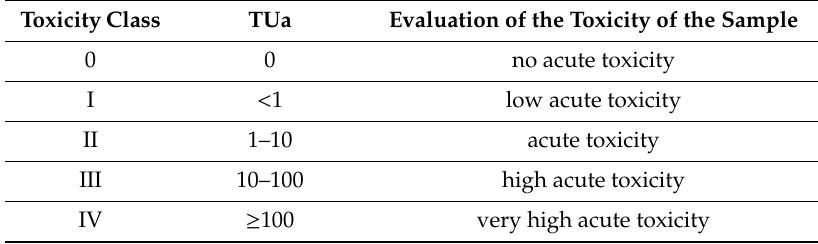
Table 2. Toxicity classification system of environmental samples proposed by Persoone